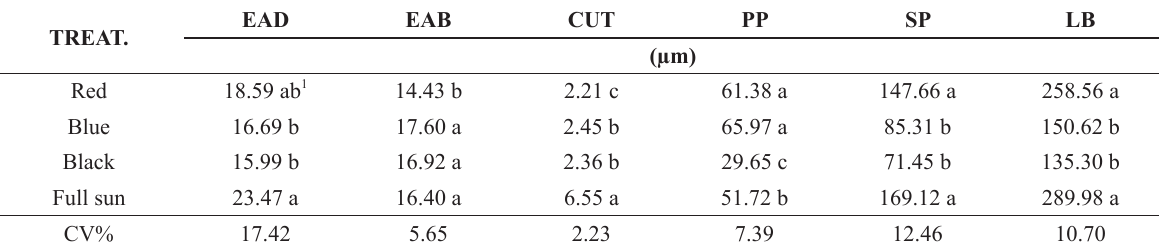
Epidermal thickness in the adaxial face (EAD), epidermal thickness in the abaxial face (EAB), cuticle thickness (CUT), palisade parenchyma thickness (PP), spongy parenchyma thickness (SP) and leaf blade thickness (LB). Leaf tissue features in a cross section of P. cablin grown under full sun and under colored shade nets, at 50% shading.